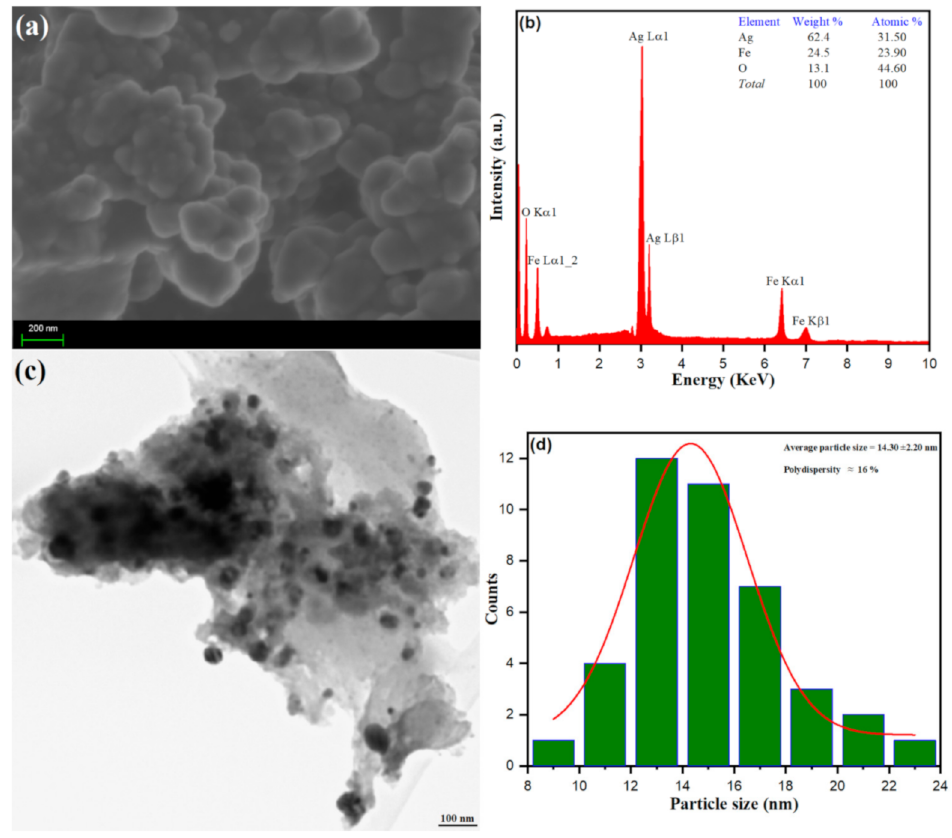
Figure 3. ( a ) SEM, ( b ) EDX ( c ) TEM and ( d ) particle size distribution of Ag–Fe